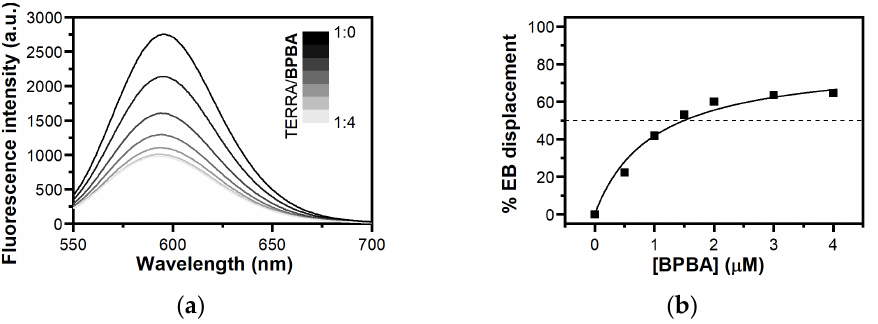
Figure 5. ( a ) Fluorescence spectra for ethidium bromide displacement from TERRA G4 in the presence of increasing concentrations of BPBA ; ( b ) Dose–response curves from FID experiments.